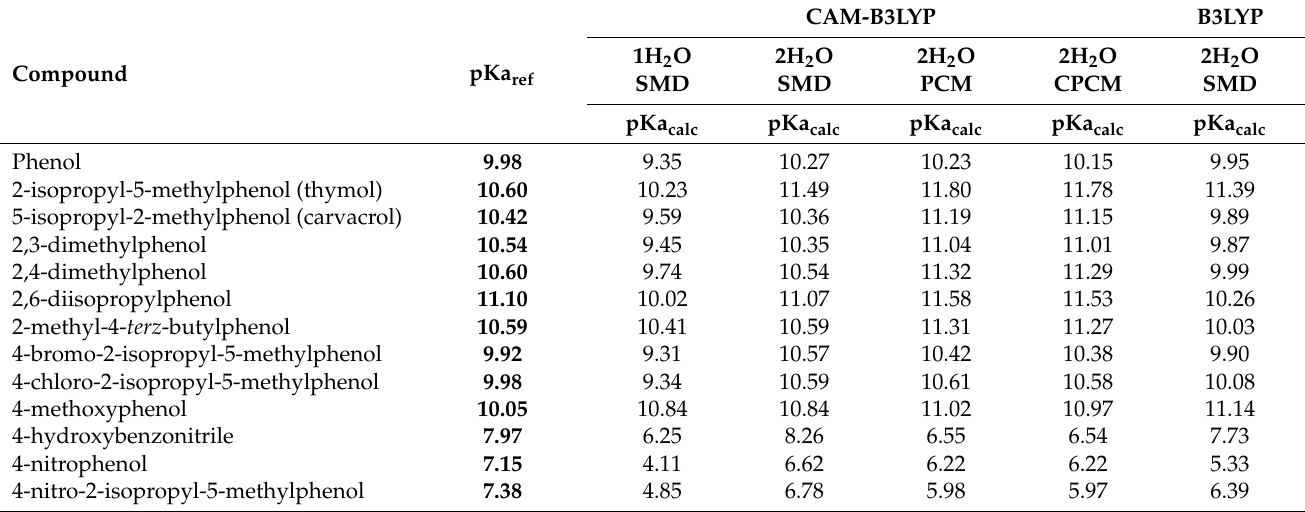
Table 4. Calculated pKa for phenol derivatives with 6-311G+dp basis set.